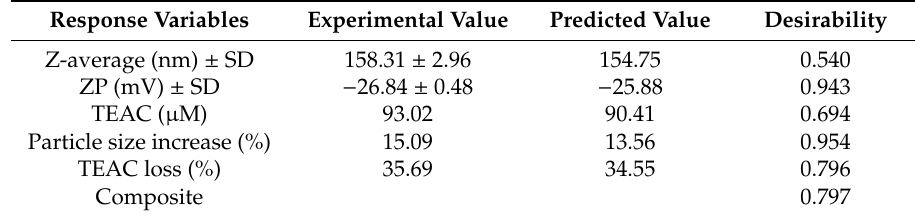
ZP and TEAC are zeta potential and trolox equivalent antioxidant capacity,